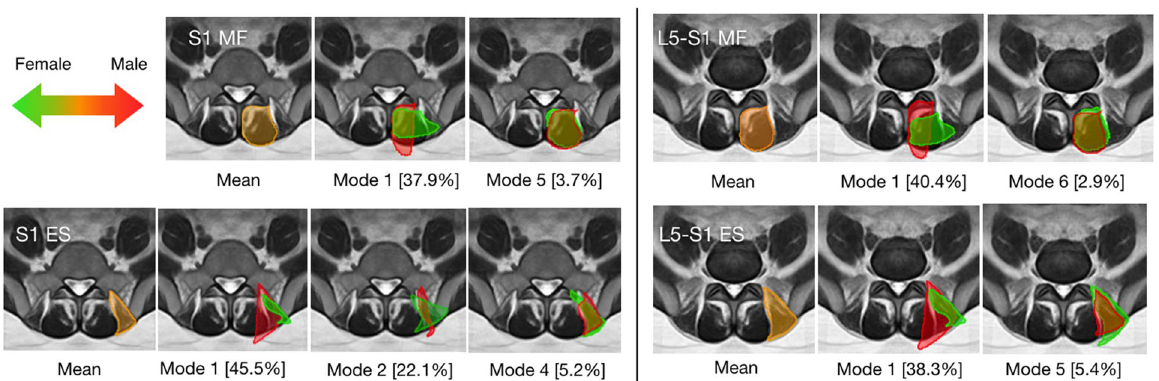
Figure 4. Modes of the multifidus (MF) and erector spinae (ES) shape associated with sex. The mean shape is shown in orange overlaid on population-averaged MRI templates. The trend of shape variation towards female sex is in green and the opposite is in red. For each mode, threefold standard deviations from the mean shape are depicted for both directions of shape variants, and the percentages of shape variance explained are included in [] for all